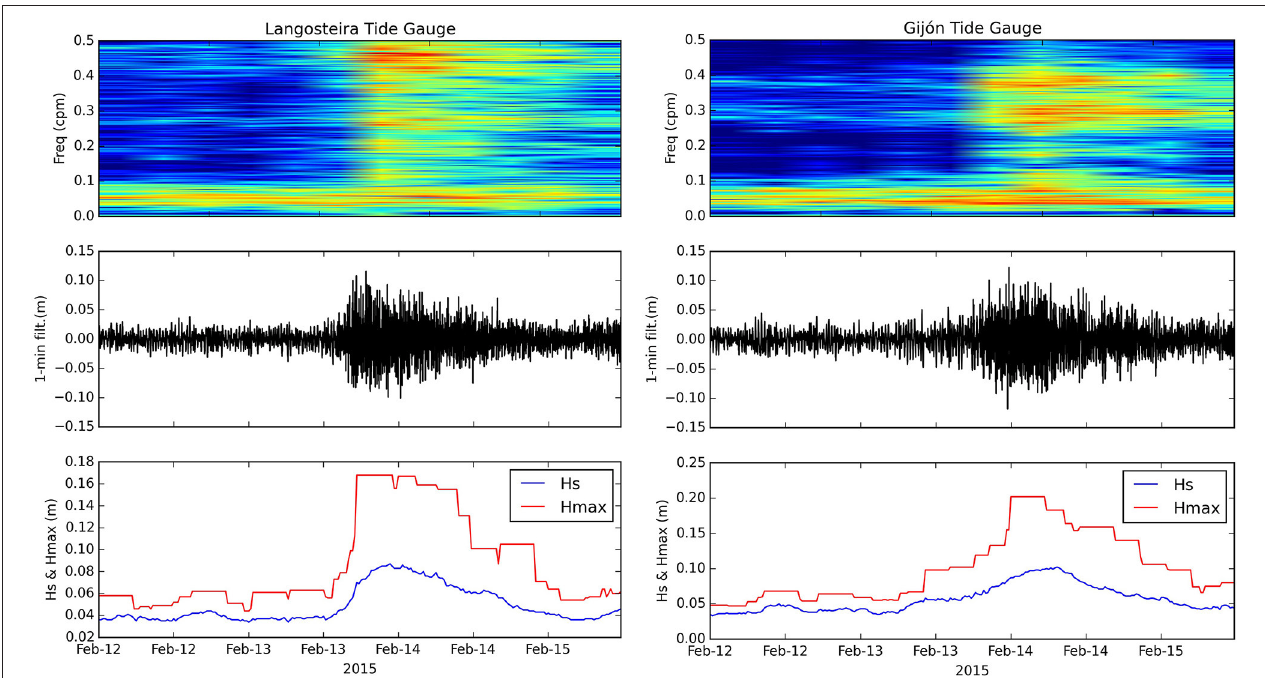
FIGURE 12 | Top: spectrogram of 1min high-pass filtered sea level data at Langosteira (left) and Gijón (right) tide gauges, showing the temporal evolution of the spectra along February 12–15th 2015. Applied to 512 points windows with 128 points overlap (colors in variance units). A constant signal with periods in the range of 15–25min is present before the event at both stations; new signals for lower periods (until 2 or 2.5min) appear when the event starts; middle and bottom: 1min high-pass filtered time series and corresponding estimated “seiche” amplitude (half the significant wave height H s and the maximum wave height H max ) during this period (zero-crossing